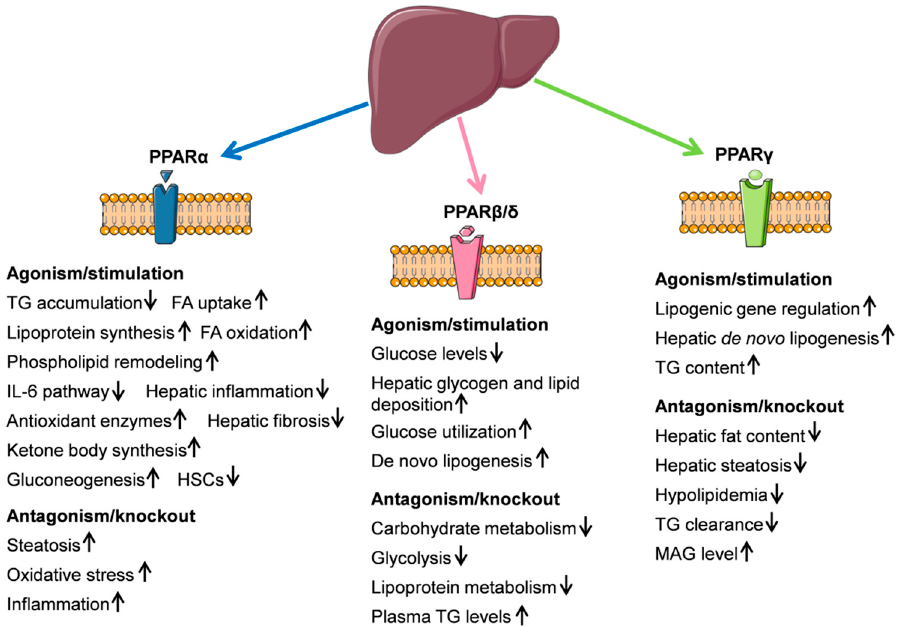
Figure 3. Schematic illustration of peroxisome proliferation-activated receptor (PPAR) function in liver metabolism. ( ↑ ) and ( ↓ ) define up or down regulation. Most findings were generated in rodent models. This figure was prepared using a template on the Servier Medical Art website (Available at: http://smart.servier.com/).